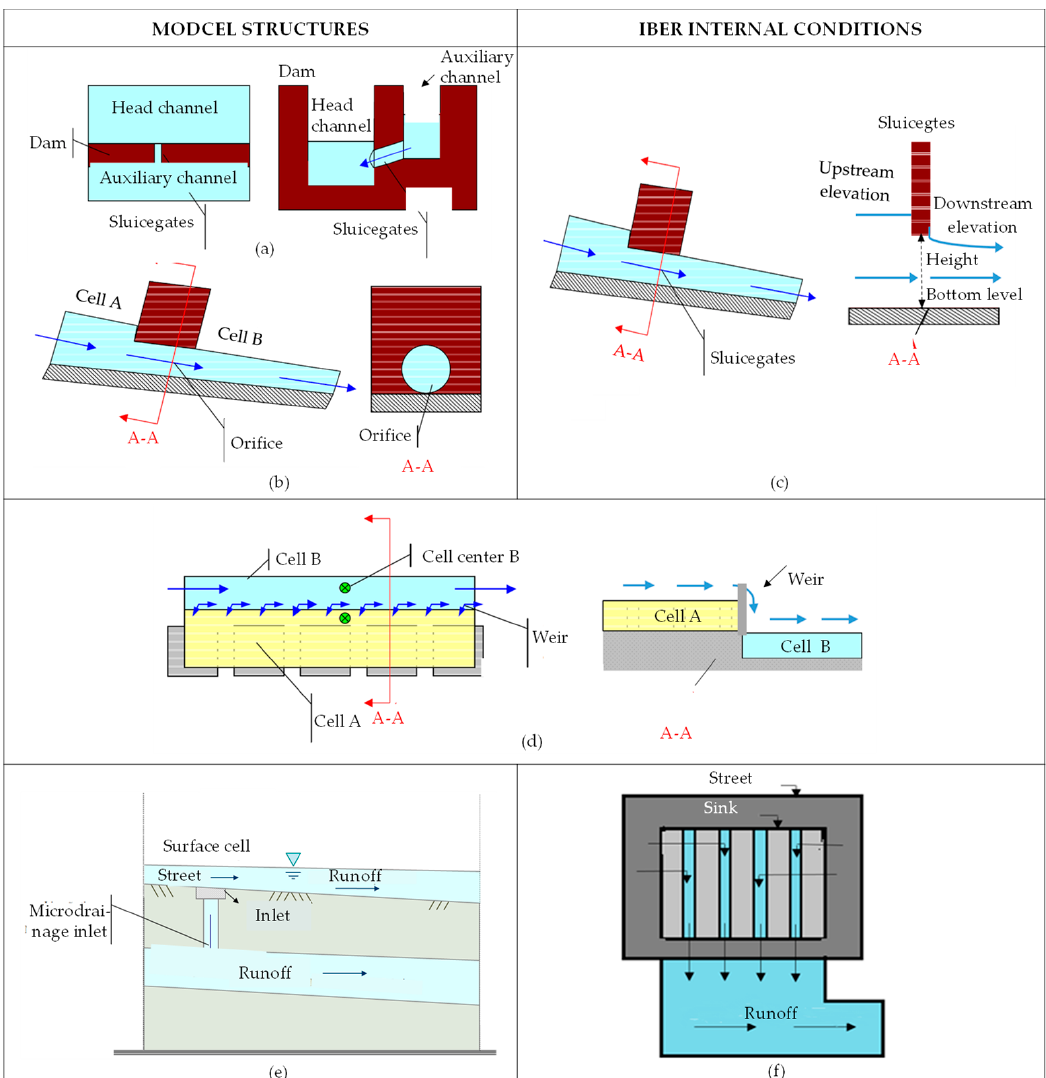
Figure 3. Correspondence of MODCEL connections to IBER types: ( a ) gate type and ( b ) orifice type; correspond in IBER to the gate type ( c ). The weir type ( d ) coincides in both models. The connection of a surface cell with an underground conduit € corresponds to a sink in IBER ( f ). Source: own elab- oration from [33,34].